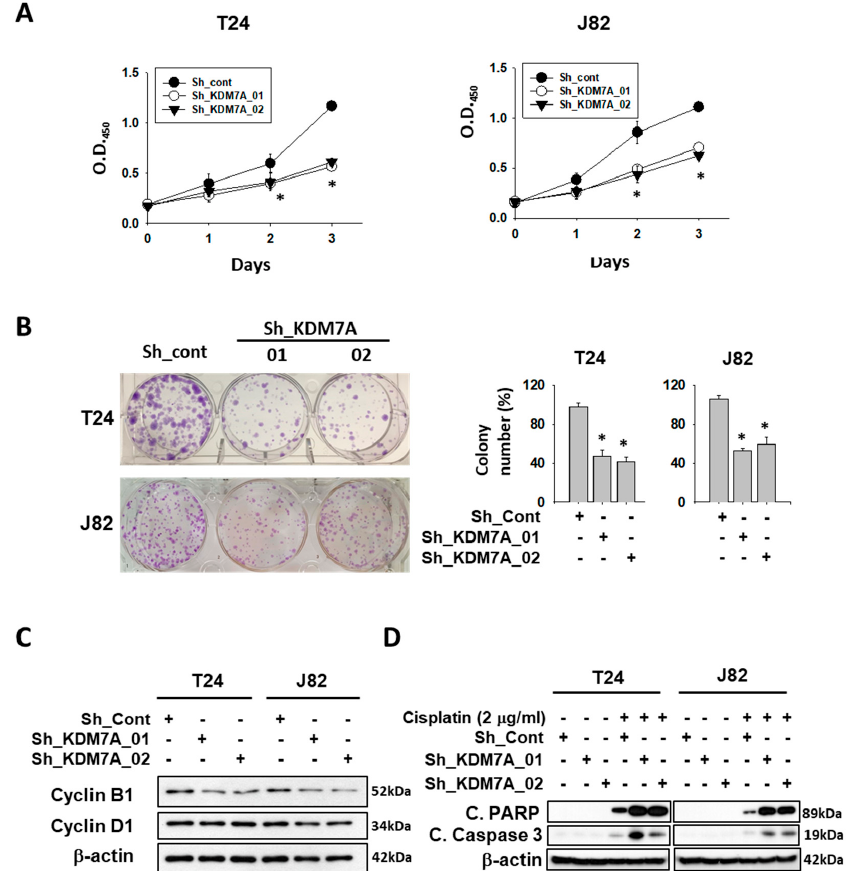
Figure 3. Histone demethylase KDM7A is required for the cell proliferation and apoptosis inhibition in bladder cancer cell lines. ( A ) The time dependent viability changes of control shRNA and KDM7A shRNA expressing bladder cancer cell lines were measured using EZ-Cytox solution. Bars represent means ± SD of three independent experiments. * p < 0.05 (Student’s t -test) versus the control shRNA (sh-cont) group. ( B ) Crystal violet staining for colonies from the same number of indicated shRNA-expressing stable cells. The average number of colonies is shown in the right panel. Bars represent means ± SD of three independent experiments. * p < 0.05 (Student’s t -test) versus the sh-cont group. ( C ) The levels of cell cycle-related proteins were measured from the whole cell extracts of control and KDM7A knock-down cells. ( D ) The apoptotic proteins were detected in the cisplatin-treated KDM7A knock-down bladder cells. Whole-cell lysates were analyzed with the indicated antibodies.